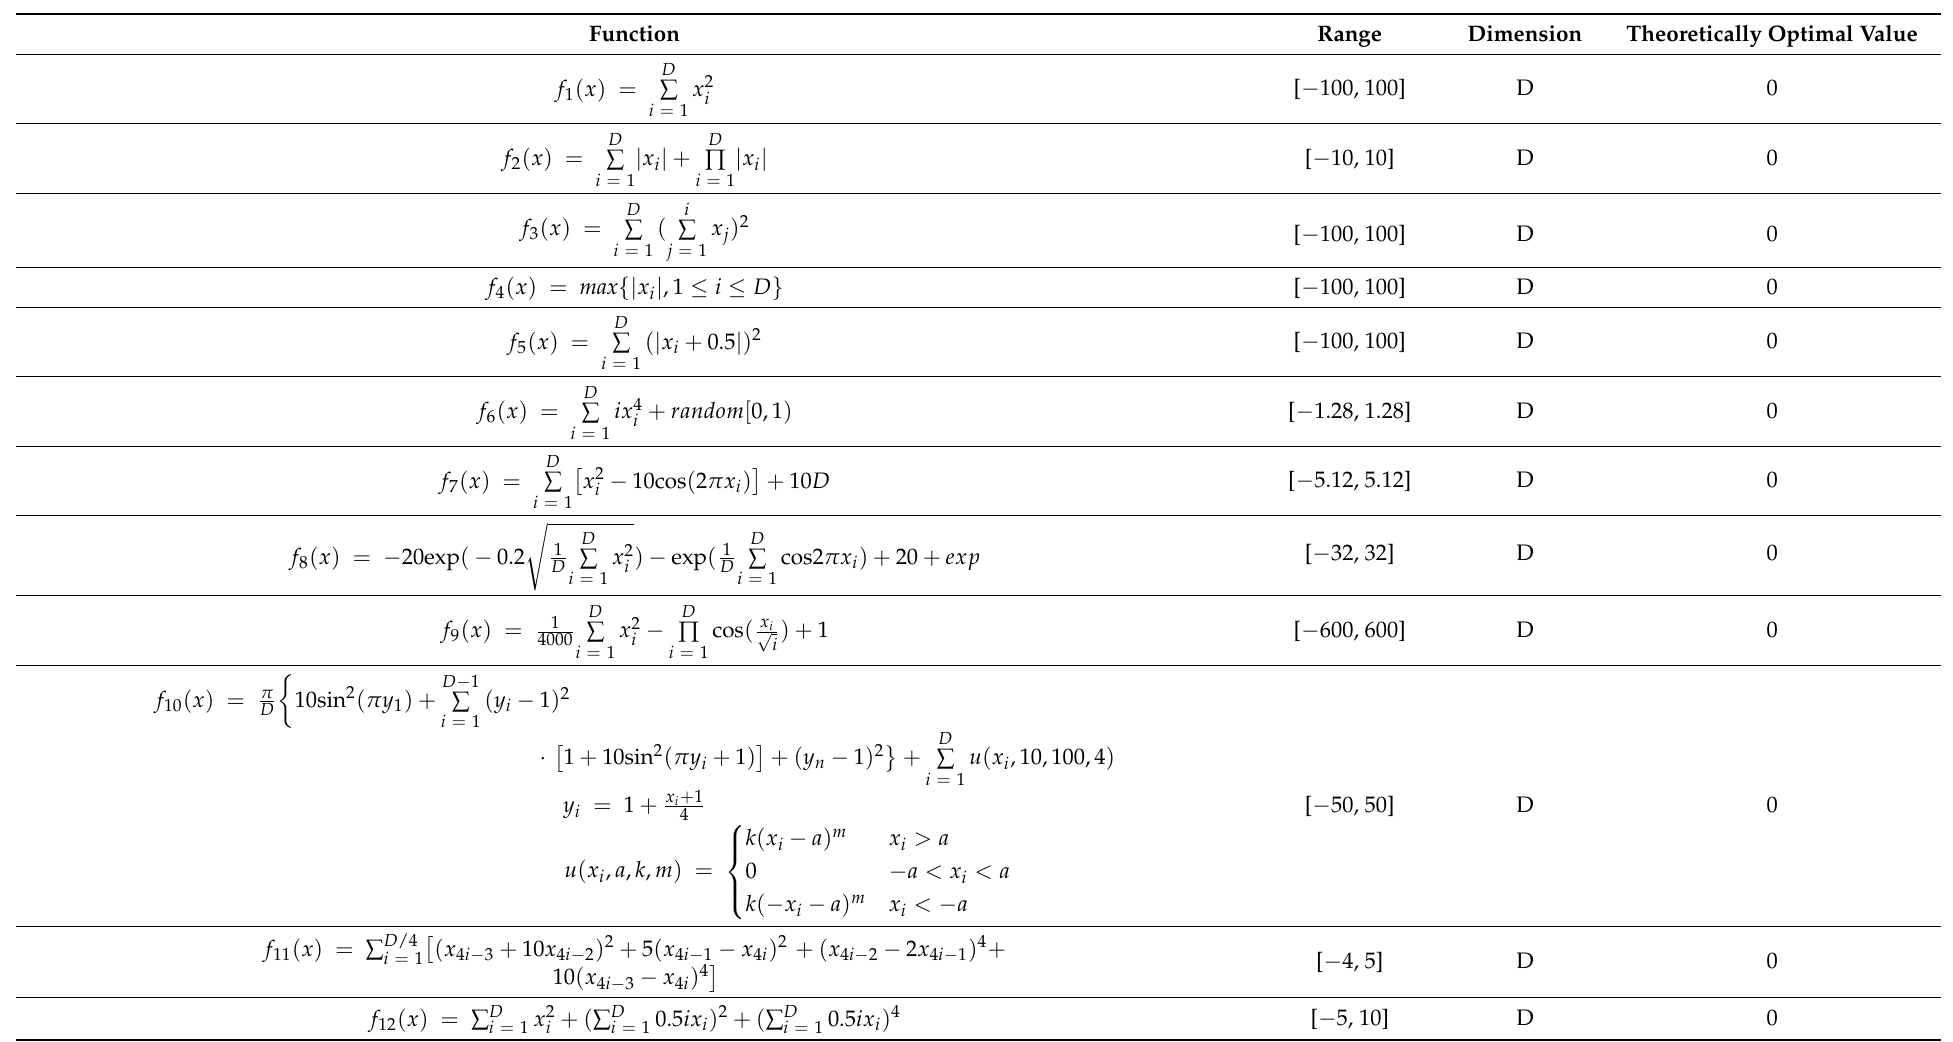
Table 1. Test functions and